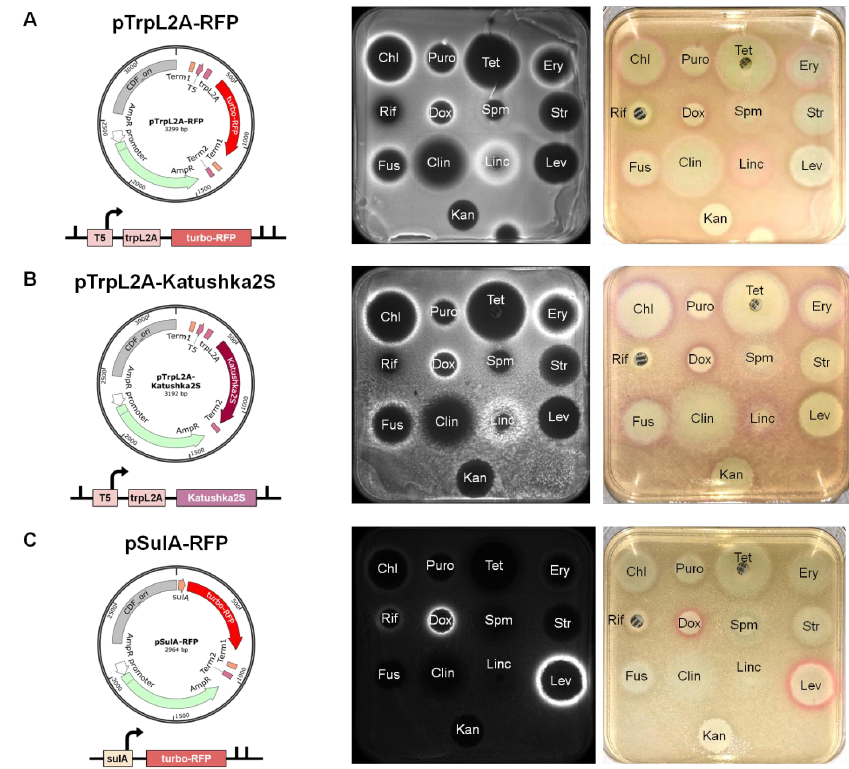
Figure 2. New reporter constructs pTrpL2A-RFP ( A ), pTrpL2A-Katushka2S ( B ) and pSulA-RFP ( C ) were created, transformed into the E. coli Δ tolC strain and validated with a panel of antibiotics. The plates ( A , C ) were scanned in the Cy3 (TurboRFP) channel; the plate ( B ) was scanned in the Cy5 (Katushka2S) channel (middle). TurboRFP and Katushka2S are visible to the naked eye in orange-red and lilac colors, respectively, in the zone of antibiotic sublethal concentrations (right). The panel of antibiotics is as follows: chloramphenicol (Chl), puromycin (Puro), tetracycline (Tet), erythromycin (Ery), rifampicin (Rif), doxorubicin (Dox), spectinomycin (Spm), streptomycin (Str), fusidic acid (Fus), clindamycin (Clin), lincomycin (Linc), levofloxacin (Lev) and kanamycin (Kan).